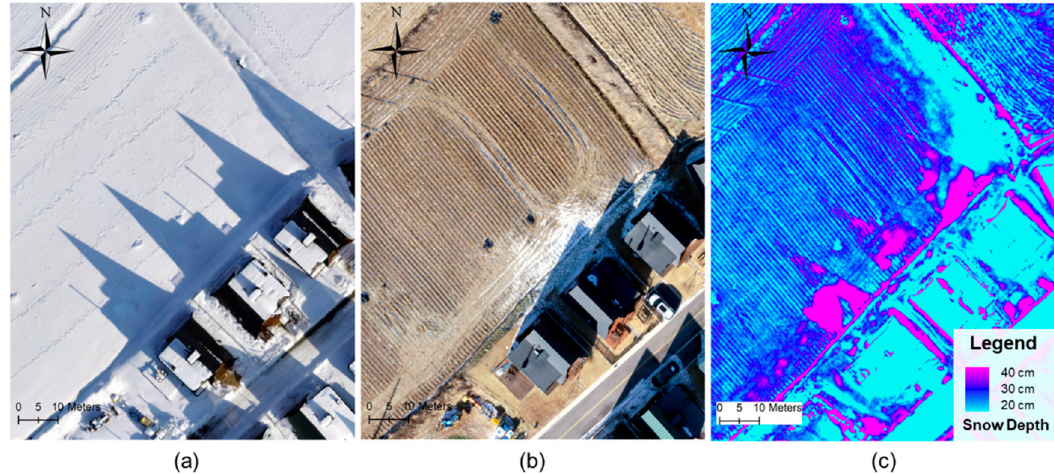
Figure 13. ( a ) Orthophoto of a part of the study site with large shadows, ( b ) the ground surface, and ( c ) the estimated snow depth map of the same